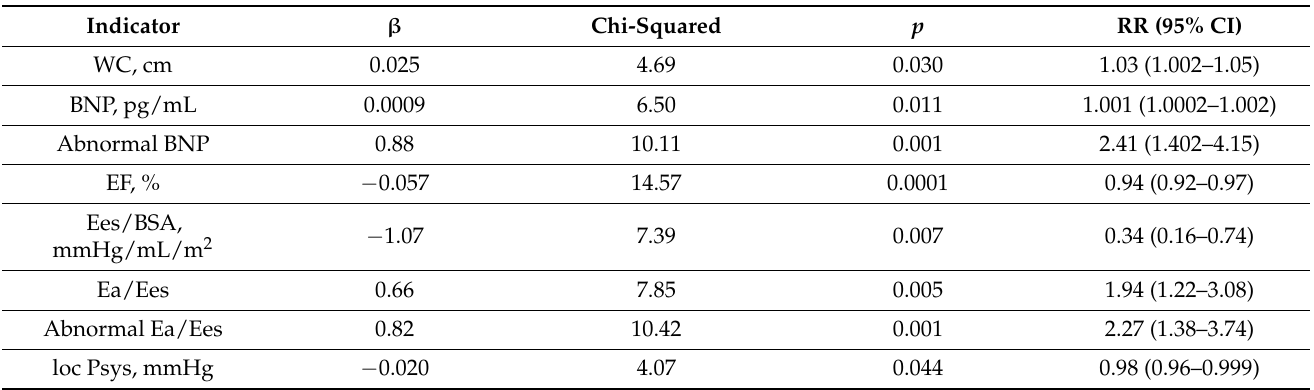
Table 3. Predictors of adverse left ventricular remodeling in patients after STEMI according to univariate